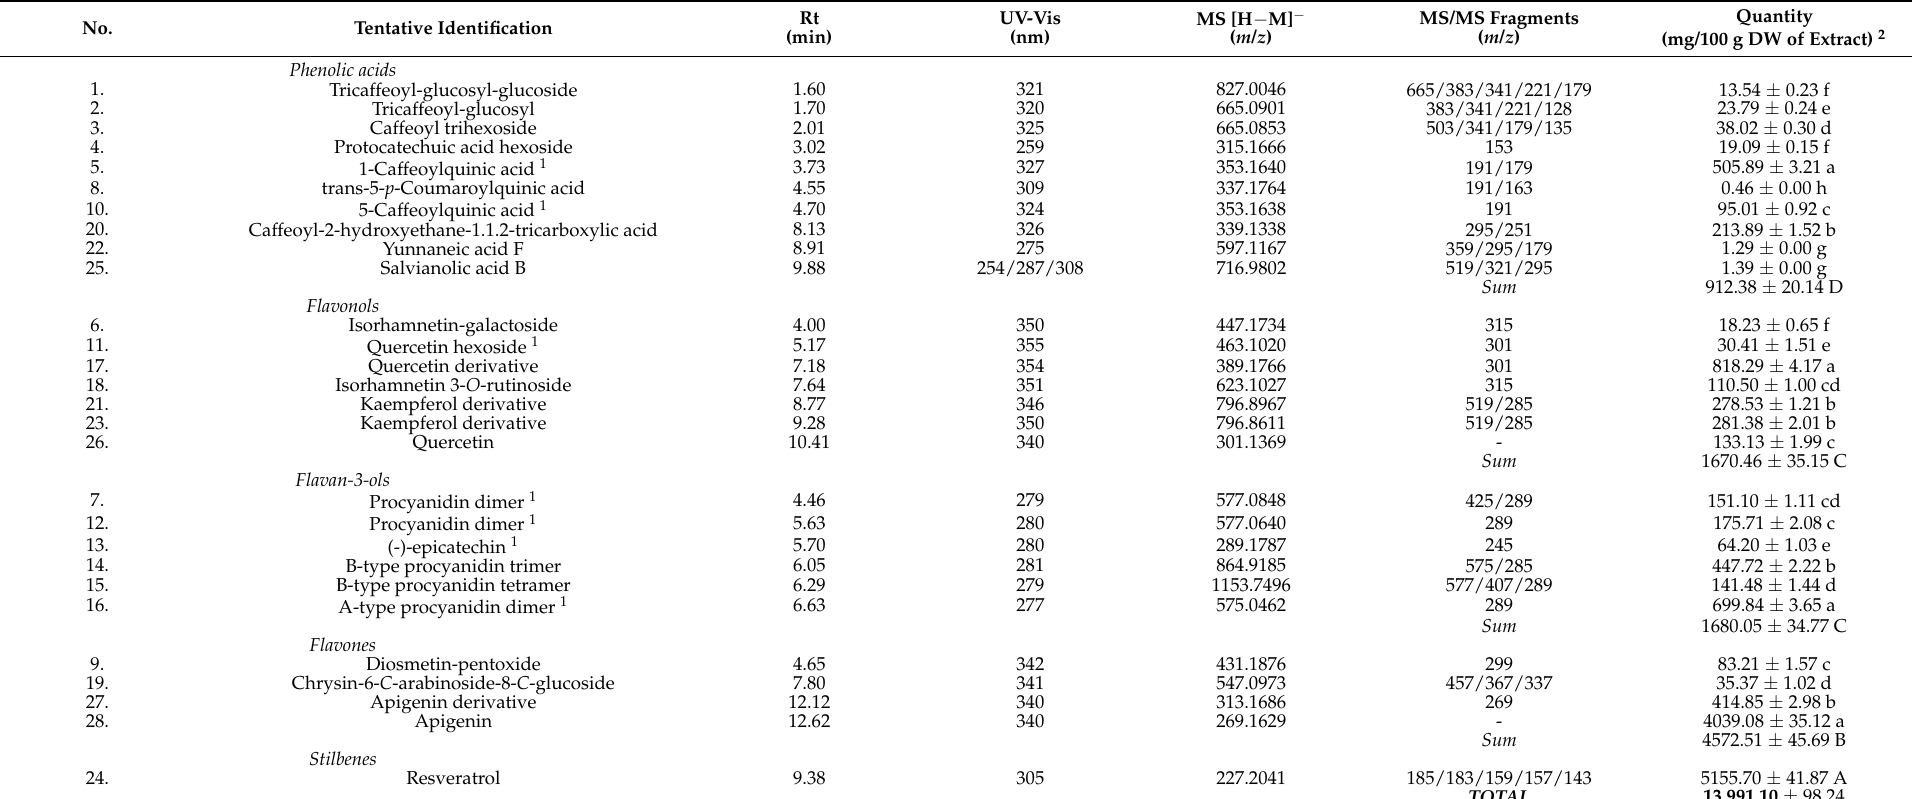
Table 1. Profile and quantity (mg/100g DW) of phenolic compounds in extract of Ganoderma lucidum